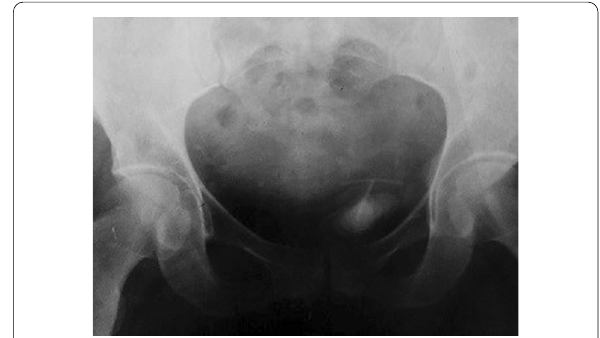
Fig. 1 X-rays pelvis showing a large vesical calculus associated with IUCD